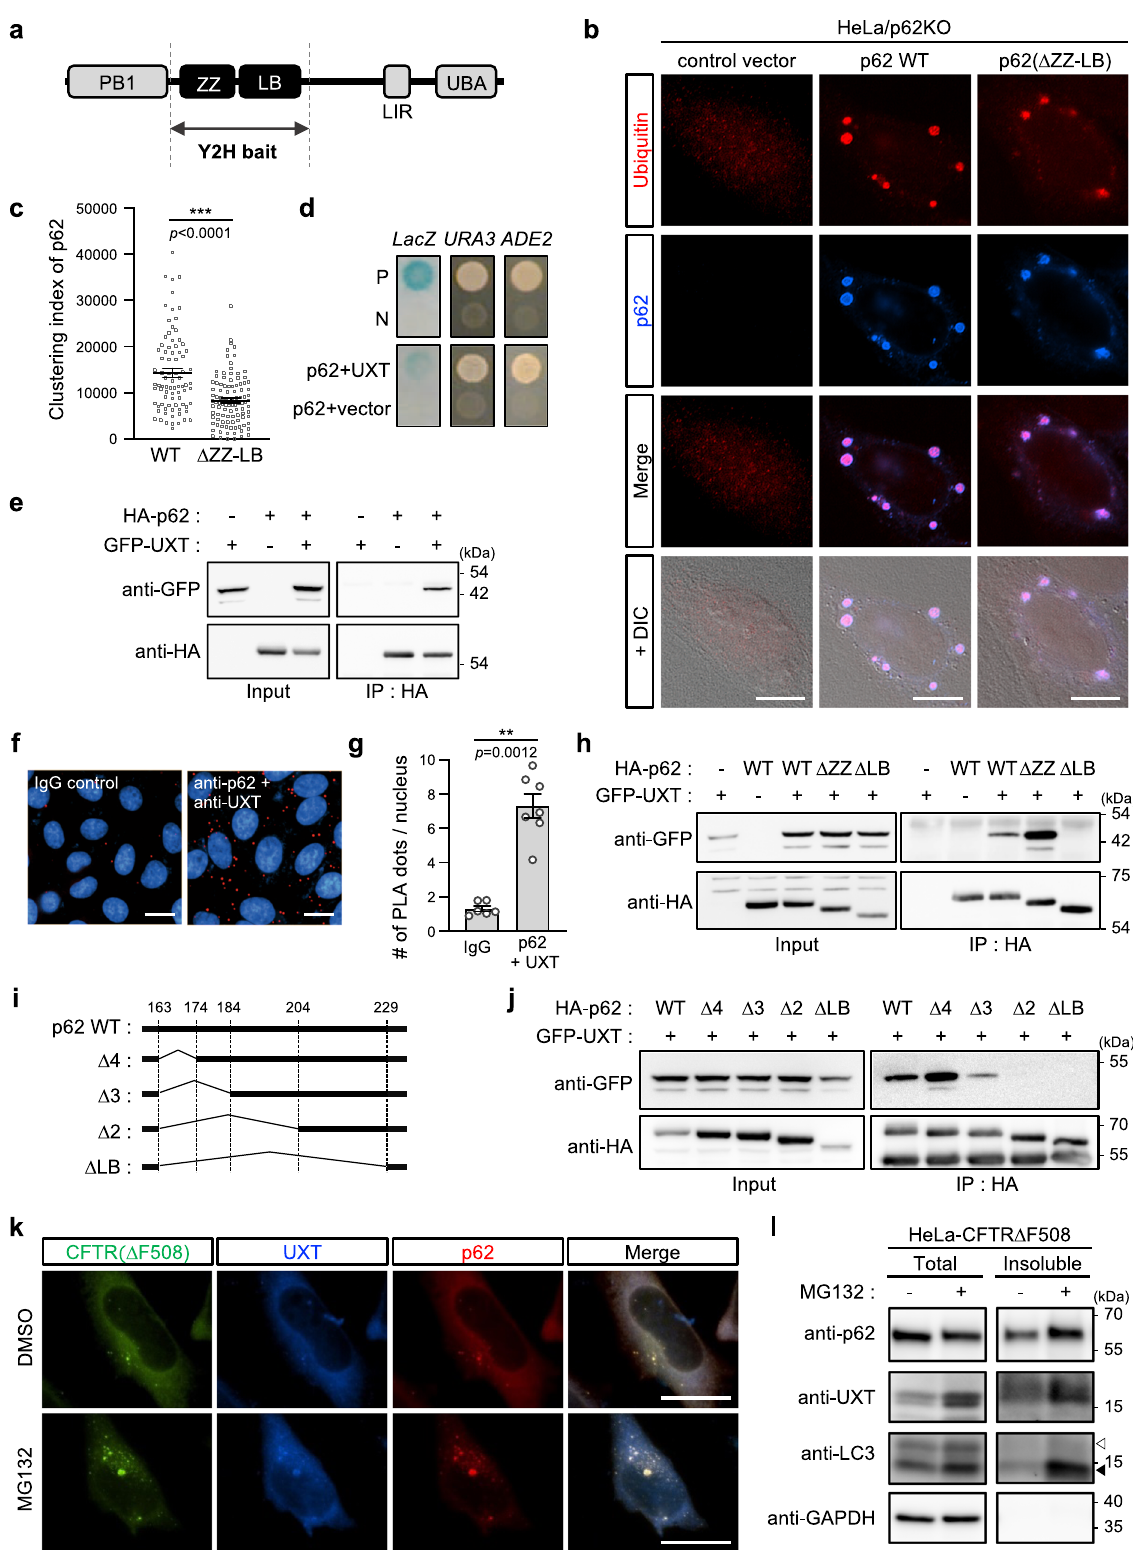
p62 and UXT may play a role in protein aggregates. The targeting of UXT to protein aggregates upon MG132 treatment was also con fi rmed by increased UXT levels in the protein aggregates containing detergent-insoluble fraction, in which increase of autophagic machinery, p62 and phosphatidylethanolamine (PE)- conjugated LC3 form (LC3-II) 39 , was observed (Fig. 1l, bottom).